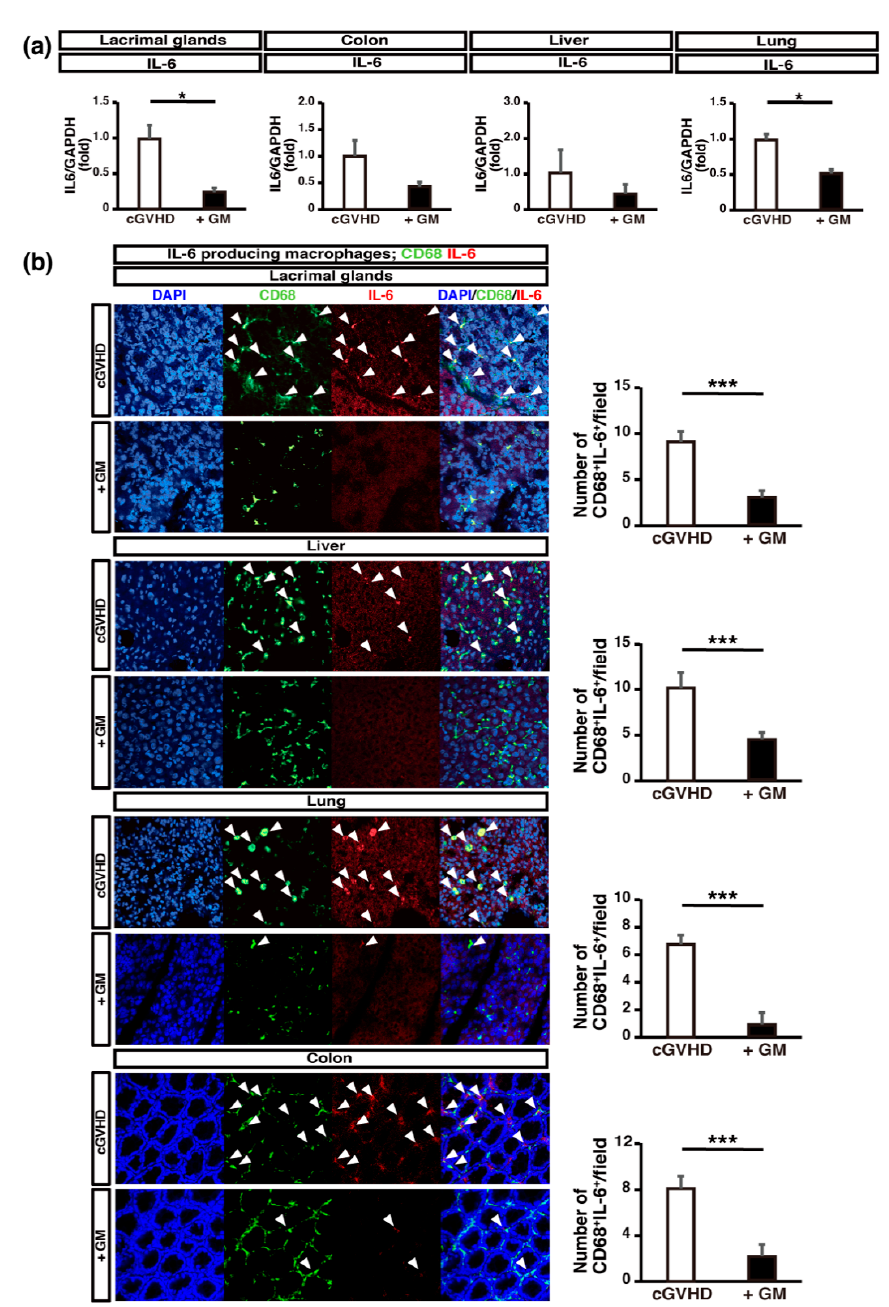
Figure 6. The infiltration of IL-6-producing macrophages in cGVHD-targeted organs is suppressed in gentamicin-treated mice: ( A ) Il6 expression in cGVHD-targeted organs. Quantitative real-time polymerase chain reaction analysis of Il6 in the organs of non-treated and gentamicin-treated (+GM) cGVHD mice. Data are presented as mean ± SEM. * p <0.05, unpaired Student’s t -test; ( B ) sections of LGs from non-treated cGVHD mice ( n = 5, five fields per sample) and gentamicin-treated cGVHD mice (+GM) ( n = 5, five fields per sample) were stained for CD68 (green) and IL-6 (red). Data are presented as mean ± SEM. *** p <0.001, unpaired Student’s t -test. Scale bar, 50 μ m.